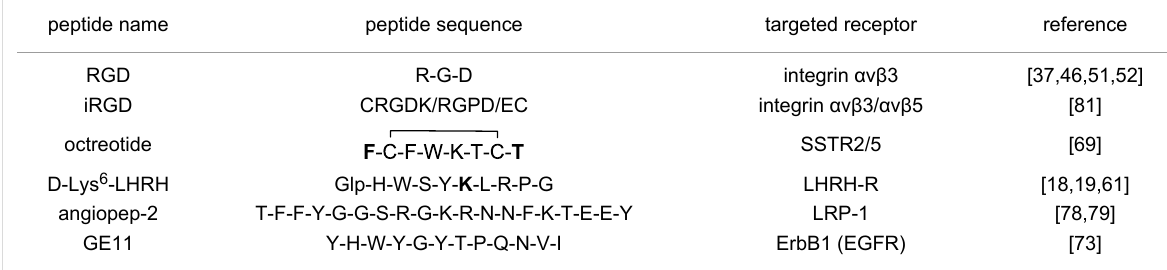
Table 1: The most common peptides (linear and cyclic) utilized for the formulation of PDCs used in cancer. Letters with bold color stand for D-amino acids.